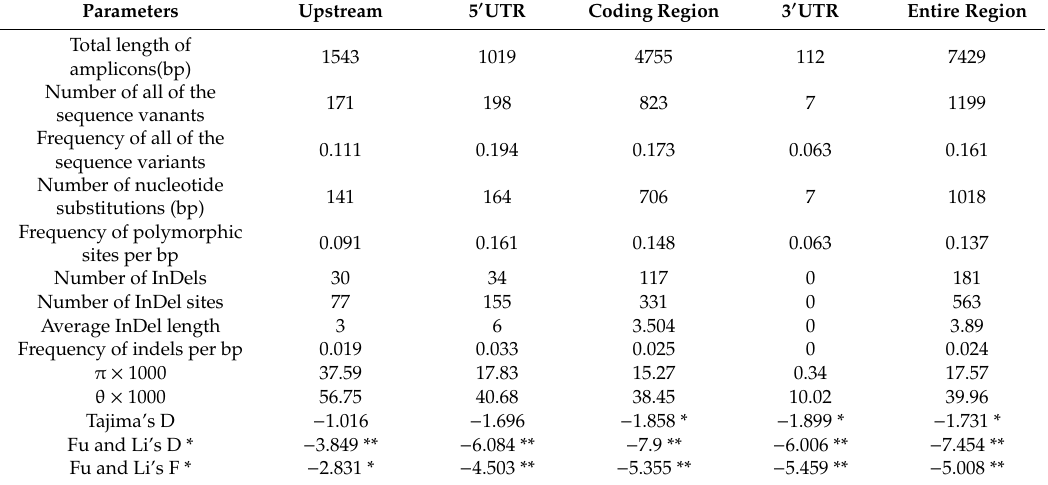
Table 1. Summary of parameters for the analysis of nucleotide polymorphisms of maize gene ZmMADS60